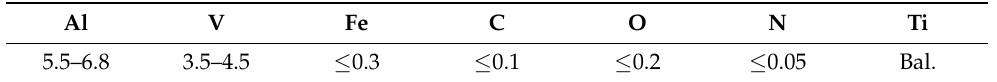
Figure 1. Optical morphology of Ti6Al4V alloy sample. Table 1. Chemical composition of the original sample (weight percentage).